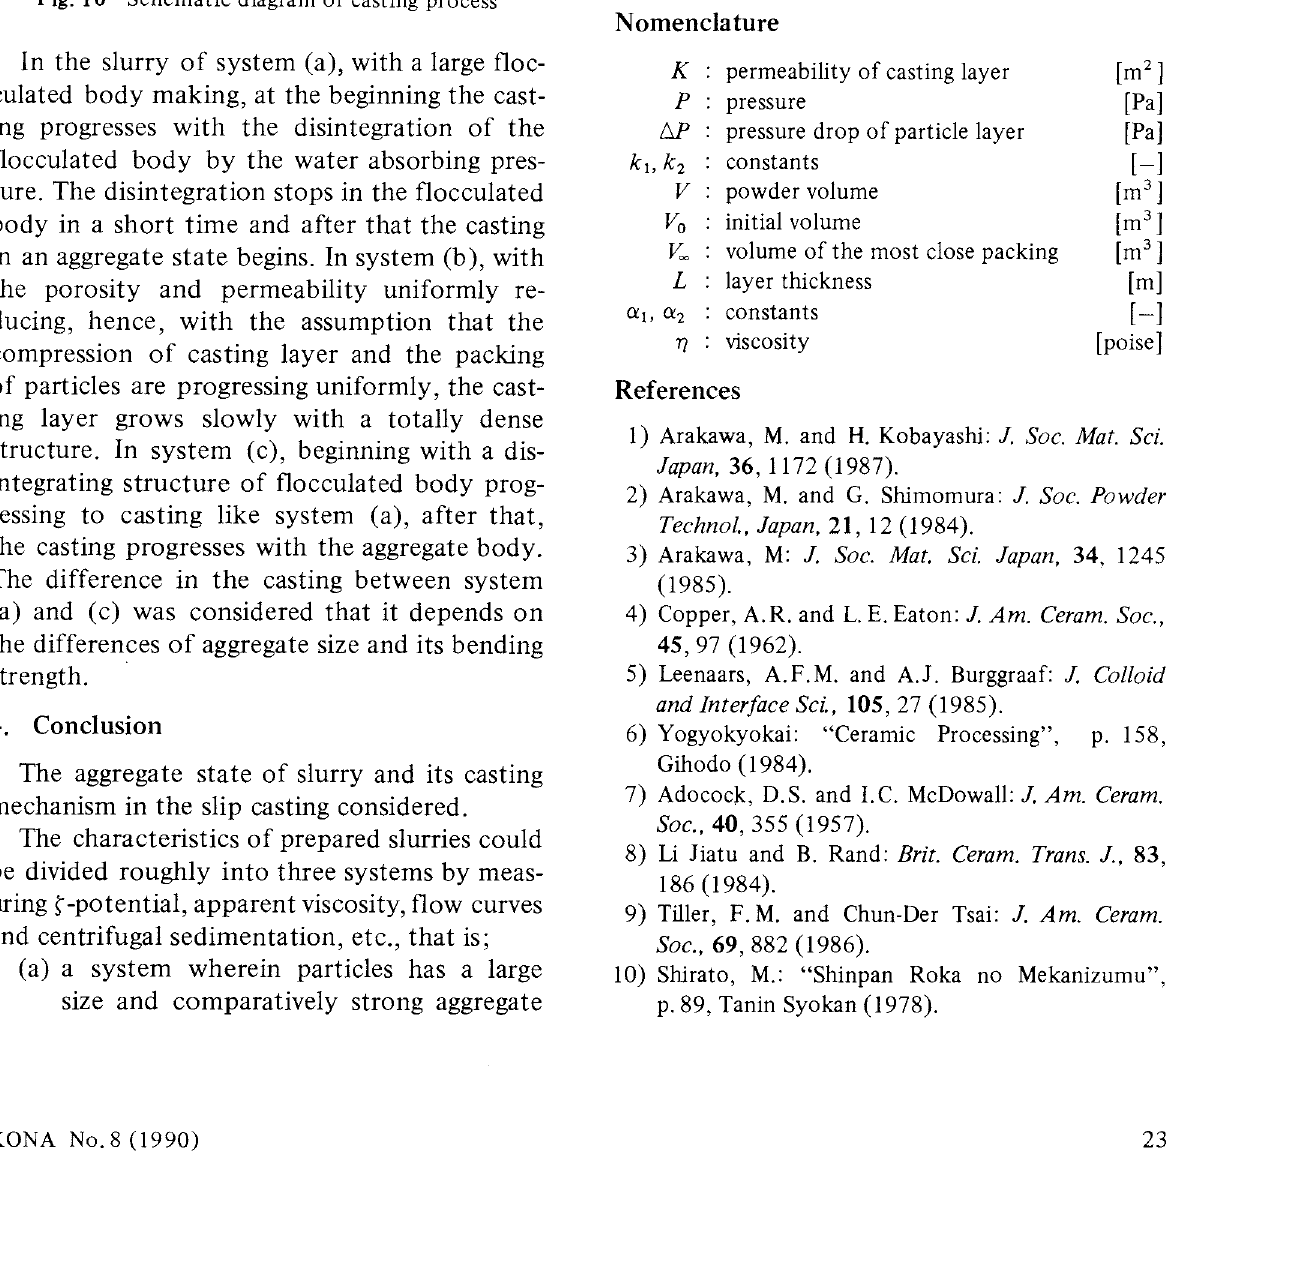
Fig. 10 Schematic diagram of casting